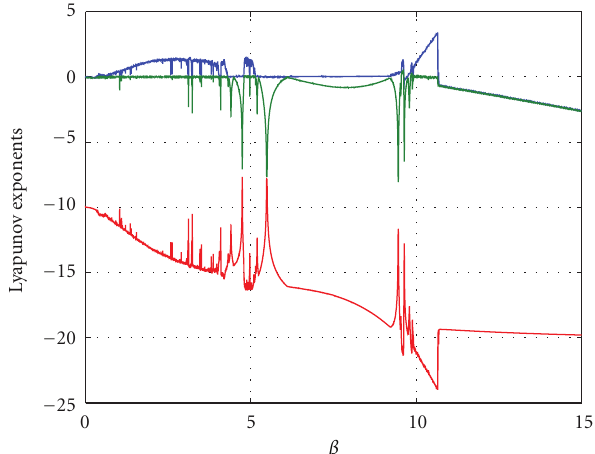
F 3: e Lyapunov exponents versus the parameter new system (2).